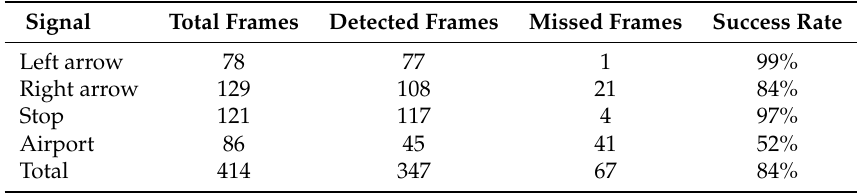
Table 2. Results of object detection with YOLO